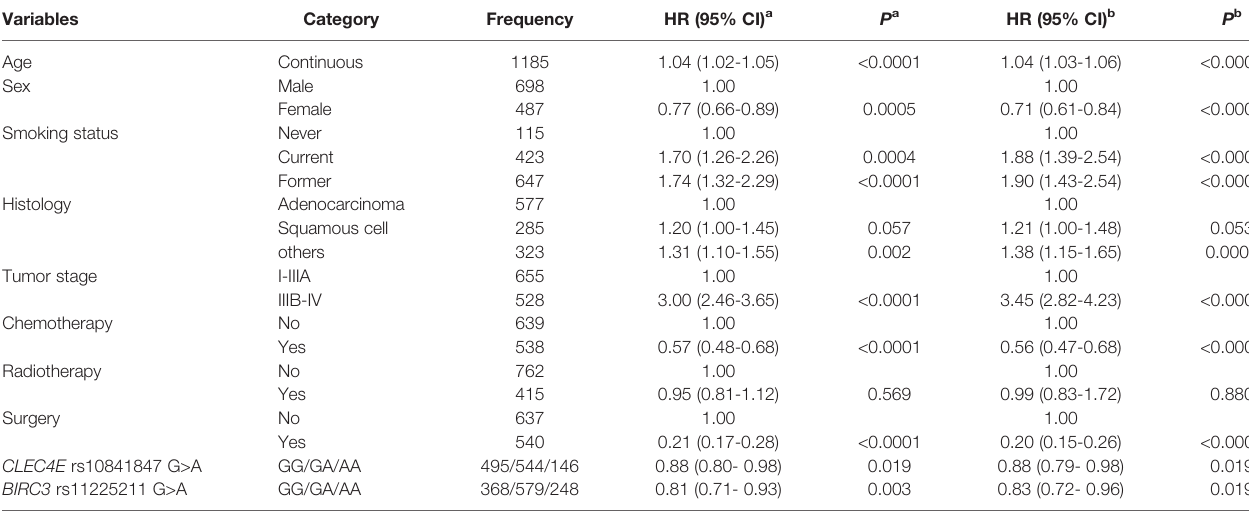
TABLE 1 | Two independent SNPs in a multivariate Cox proportional hazards regression analysis with adjustment for other covariables and additional 28 previously published SNPs for NSCLC in the PLCO Trial.